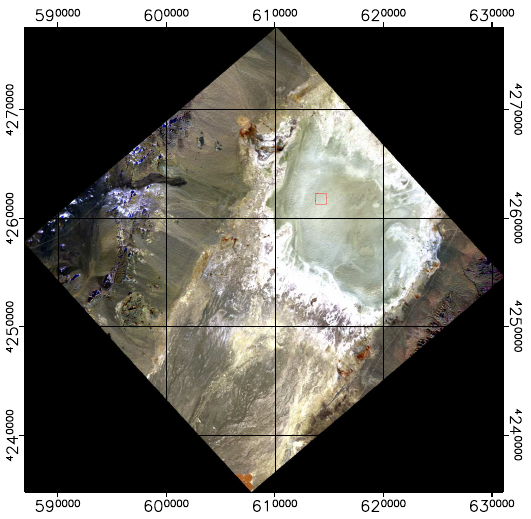
Figure 8. RVUS, 13 December 2018, L2A CIR image, non-linear stretch; coordinates given in WGS-84, UTM Zone 11 N. RadCalNet location as red